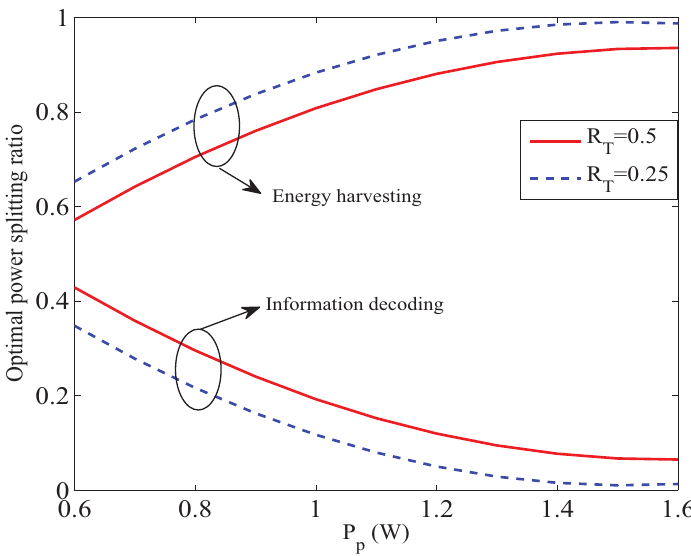
Figure 4. Optimal power splitting ratio in the first